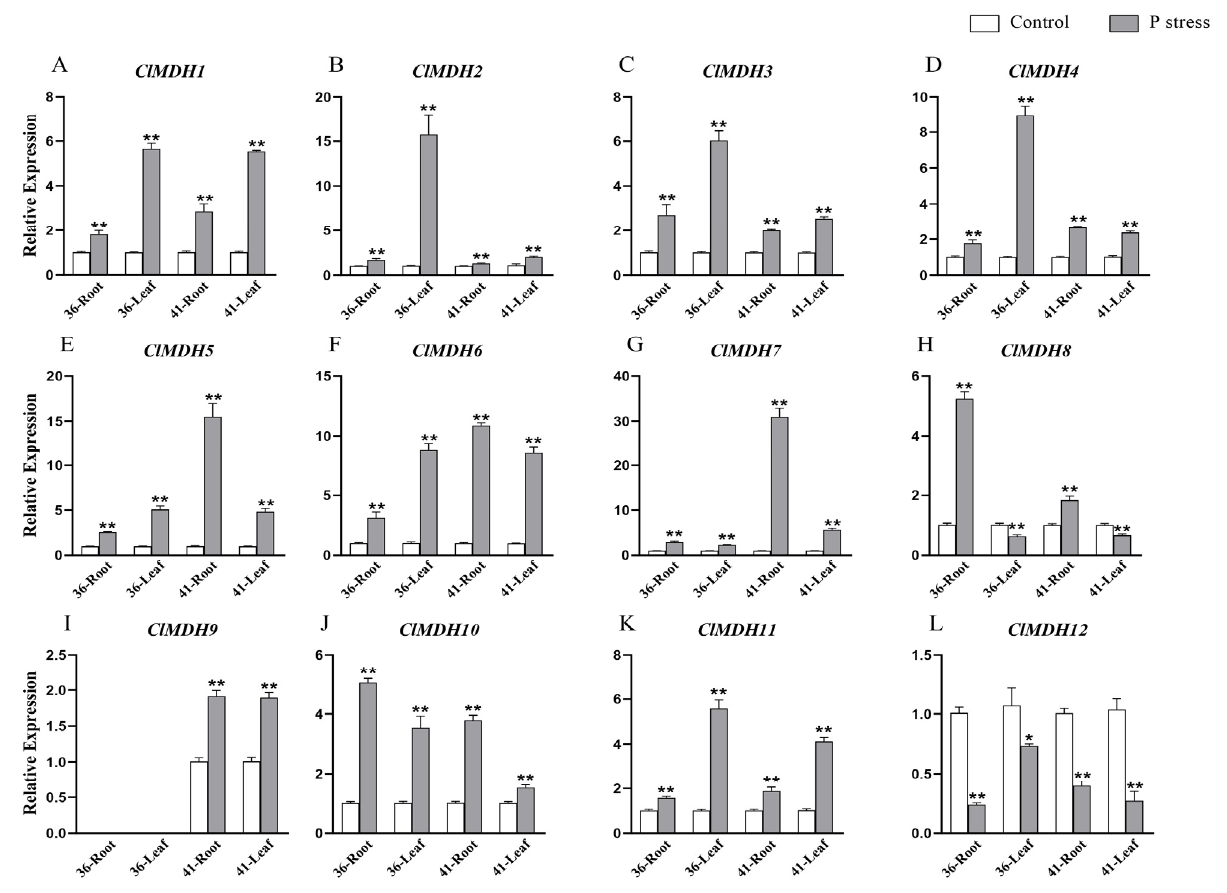
Figure 10. The relative expressions of ClMDH genes in the root and leaf tissues of clones 36 and 41 of Chinese fir under low-phosphorus stress and control conditions ( A – L ). The relative gene expression levels were calculated using the 2 −ΔΔ CT . Vertical bars represent means ± SD (n = 9). The * and ** show significance at p ≤ 0.05 and p ≤ 0.01, respectively.